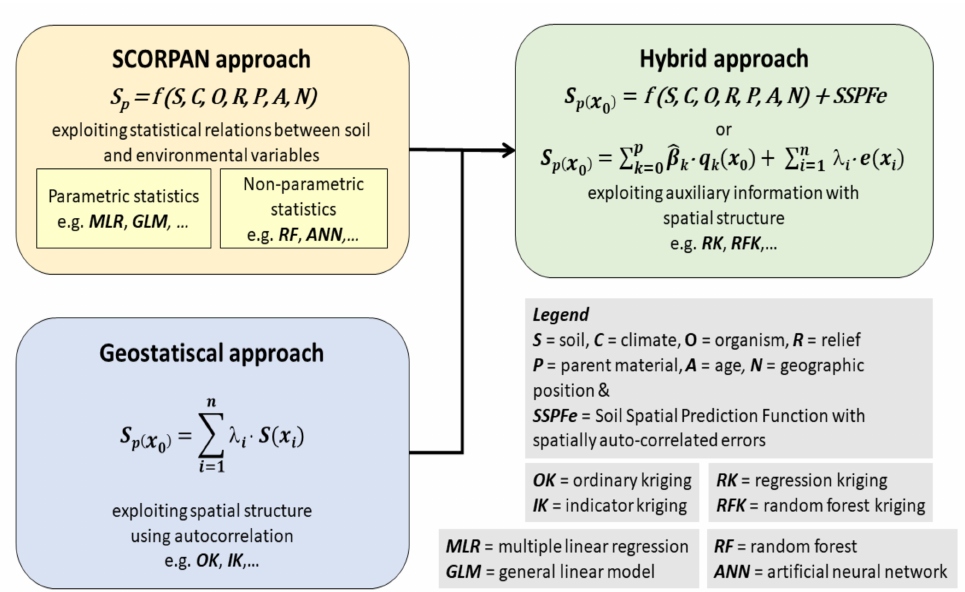
Figure 1. Integration of the SCORPAN model with geostatistical approaches for digital soil mapping (adapted from: